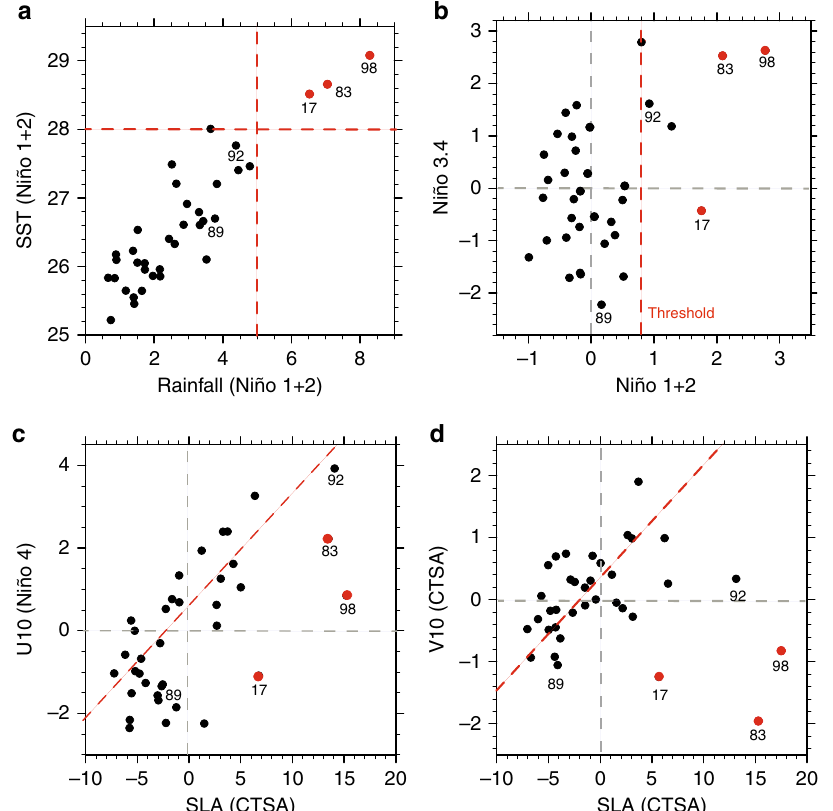
Fig. 1 Coastal El Niño-related indices over the satellite era. Scatter diagram for a March Niño 1 + 2 rainfall (mm day − 1 ) and SST (°C); b FM Niño 1 + 2 SSTAs and NDJ Niño 3.4 index (°C), red dashed line indicates convective threshold (27 °C in current climate); c FMA sea level anomalies (SLA; cm) over the coastal region of tropical South America (CTSA; 85 °W – 80 °W, 10 °S – 0°) and zonal wind anomalies (m s − 1 ) over Niño 4 region; d JFMA SLA (cm) and meridional wind anomalies (m s − 1 ) over